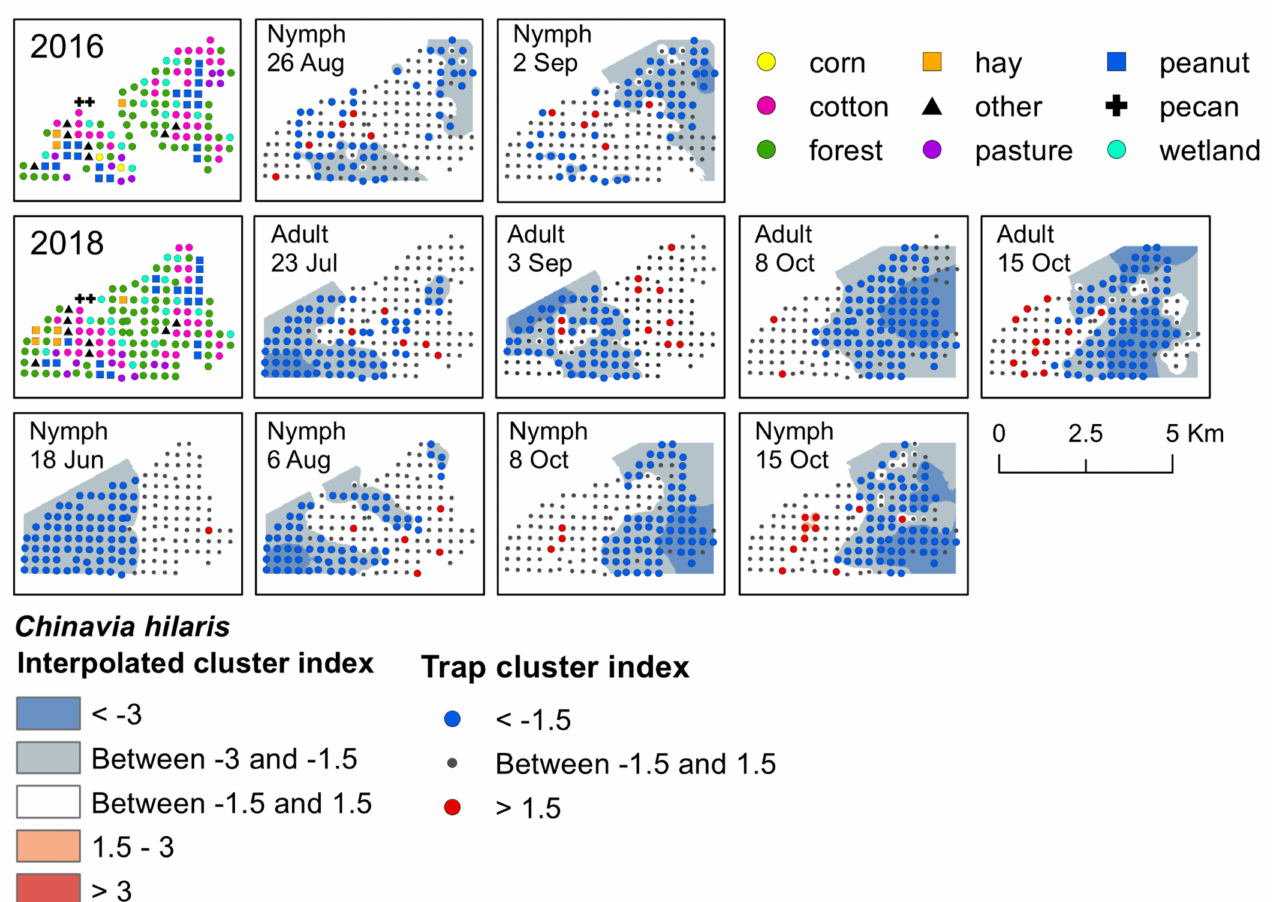
Figure 4. Red − blue plots based on interpolation of the cluster index for C. hilaris adults and nymphs from 2016–2018. Red areas (>1.5) indicate significant clustering in aggregations in distributions; blue areas (< − 1.5) indicate significant clustering as gaps in